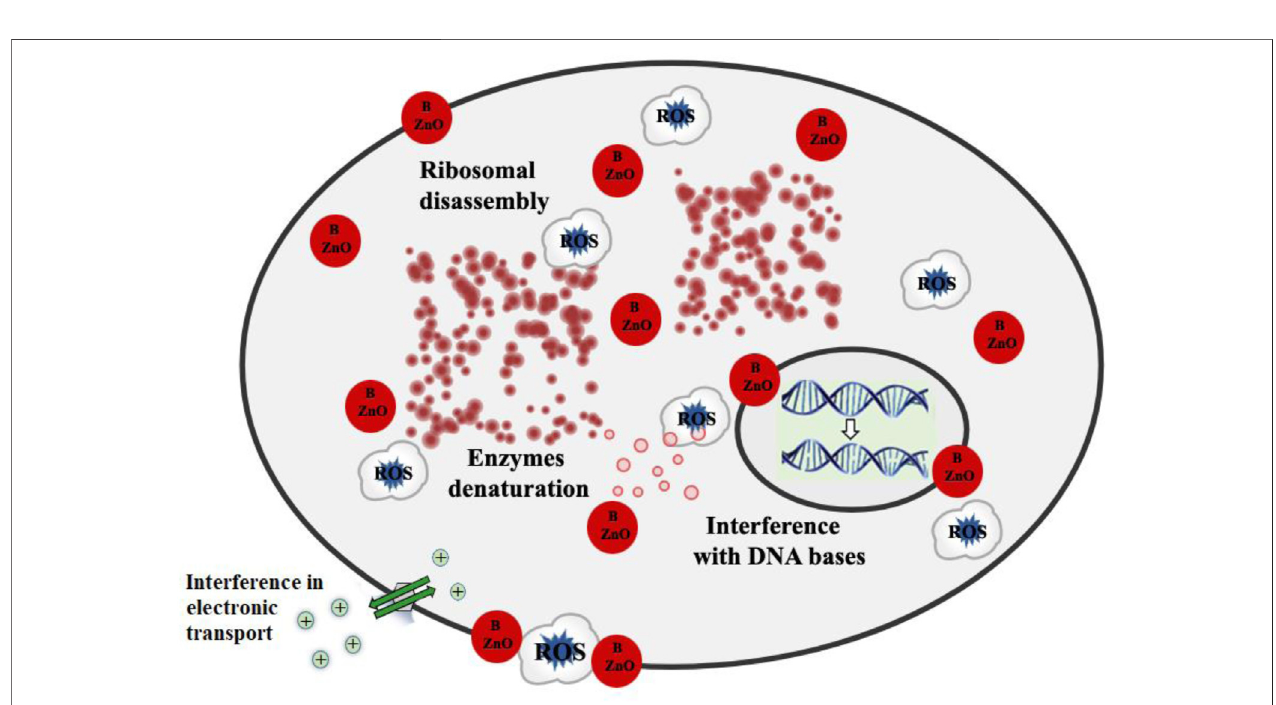
FIGURE 9 | Schematic illustration for detailed antibacterial mechanism of pure and B doped ZnO-NSs.